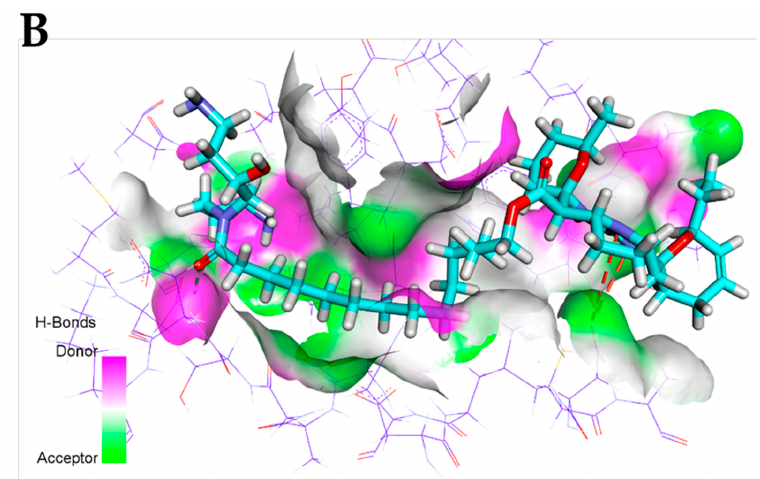
Figure 10. ( A ) Compound 5 docked into the active site of COVID-19 nsp10. ( B ) Mapping surface showing compound 5 occupying the active pocket of COVID-19 nsp10. Crambescidin 826 ( 13 ) exhibited a binding mode like that of the co-crystallized lig- ands against the COVID-19 main protease, spike glycoproteins, and nucleocapsid phos- phoprotein. The binding mode of compound 13 against the COVID-19 main protease